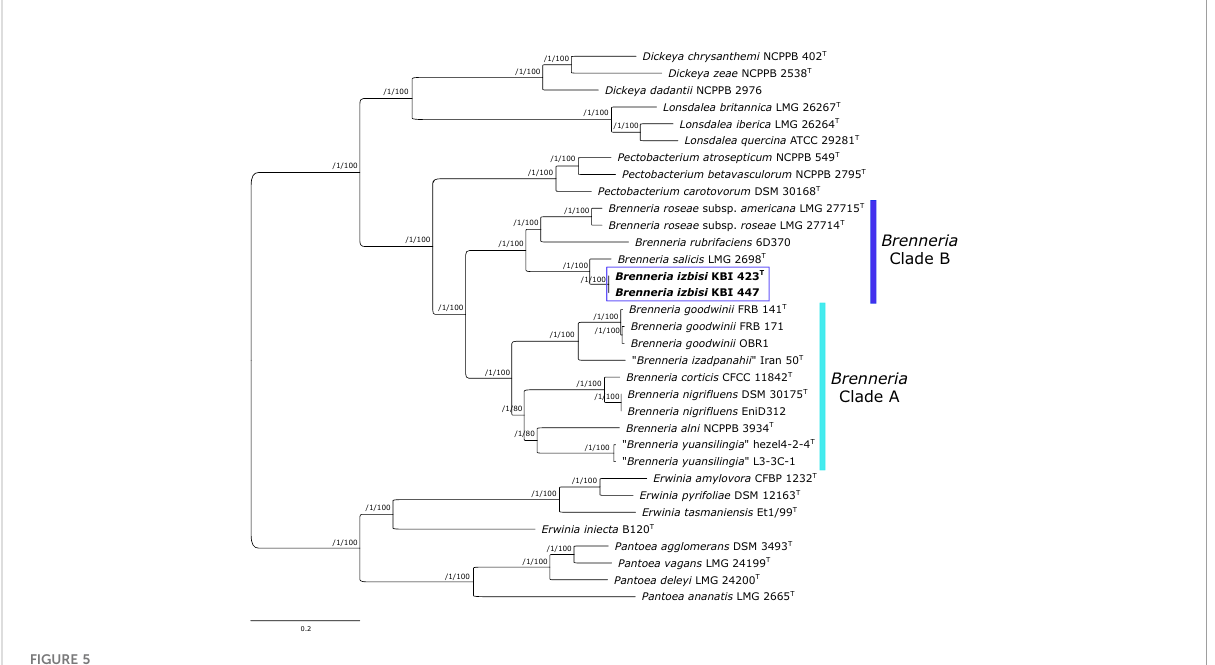
FIGURE 5 Maximum likelihood core-genome phylogenetic tree showing the evolutionary relationships between Brenneria izbisi (marked in bold and boxed) and related Brenneria spp. Reference Dickeya , Lonsdalea and Pectobacterium strains were also included in the analysis. Reference Erwinia spp. and Pantoea spp. were used as an outgroup to root the tree. The phylogeny was estimated under the GTR+F+ASC+R4 substitution model from the supermatrix obtained by concatenation of 663 top gene markers. The approximate Bayesian posterior probability values are shown at nodes. The scale bar represents the number of expected substitutions per site. DDBJ/ENA/GenBank whole-genome accession numbers are shown in Table S3. Brenneria clades A and B de fi ned by Bakhshi Ganje et al. (2021) are indicated on the